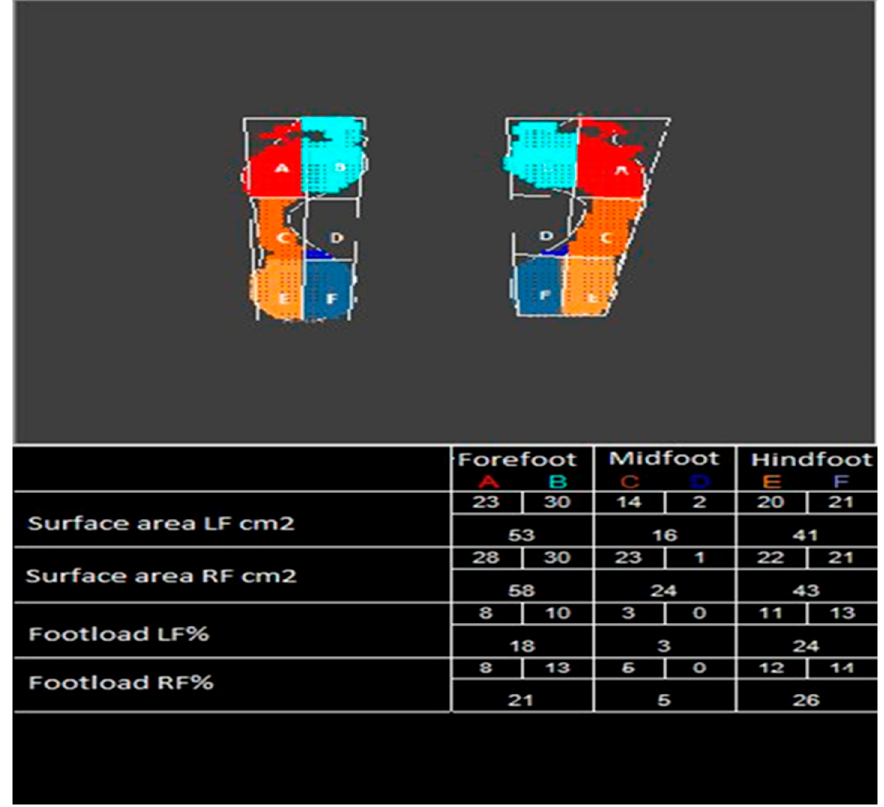
Figure 2. An example of the foot loading test outcome, under static conditions; demarcation of respective zones within the plantar part of the foot. Source: Own research material.